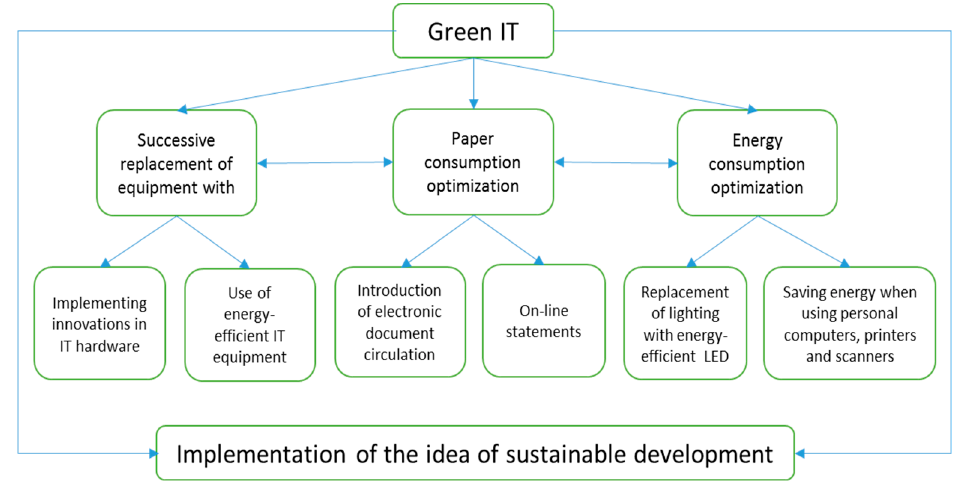
Figure 5. Chosen determinants of the idea of sustainable development. Source: Own study.